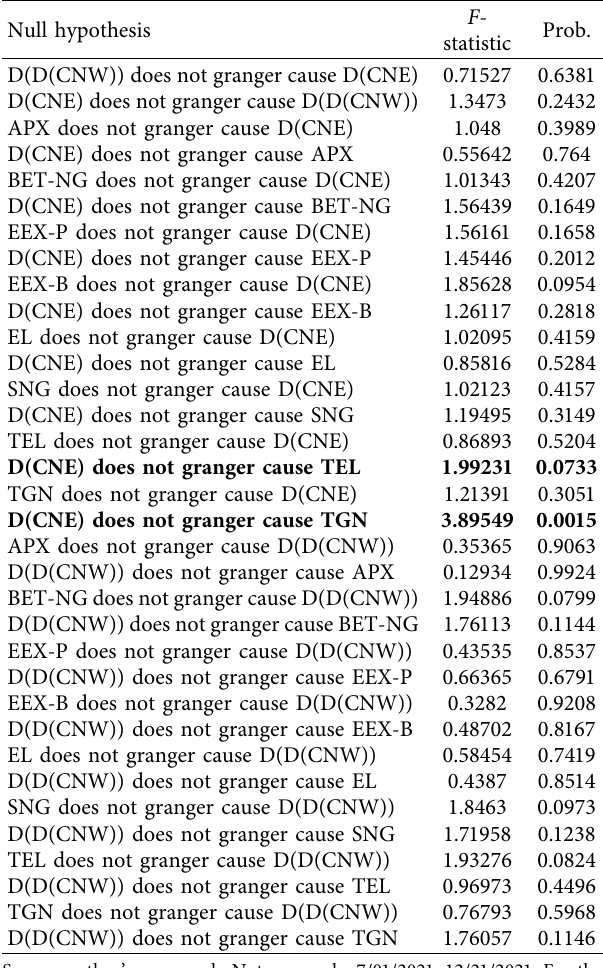
Table 13: Results of granger causality